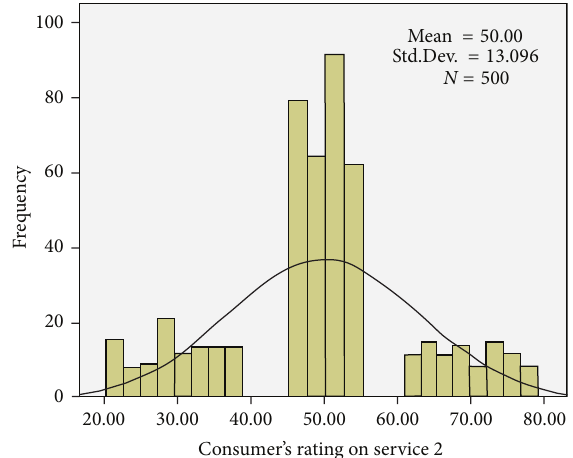
Figure 6: Distribution of rateValue for service 2 in the experiments ( 𝑁 = 500 users).